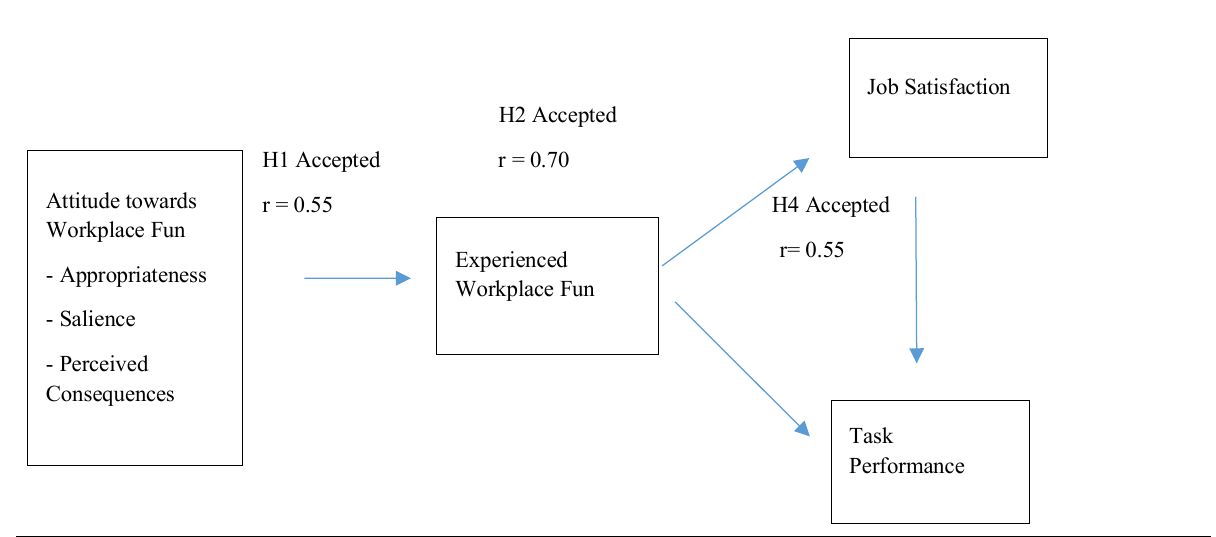
Figure 3: Summary of Hypotheses